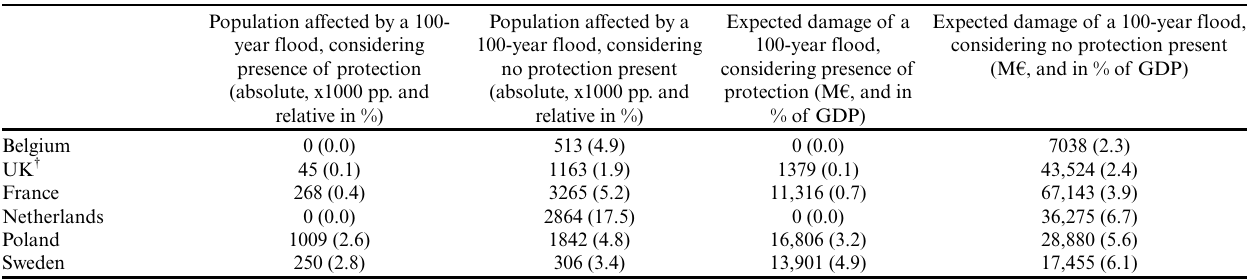
Table 3 . Characterizing flood risks in the six countries. Population affected by a 100- year flood,